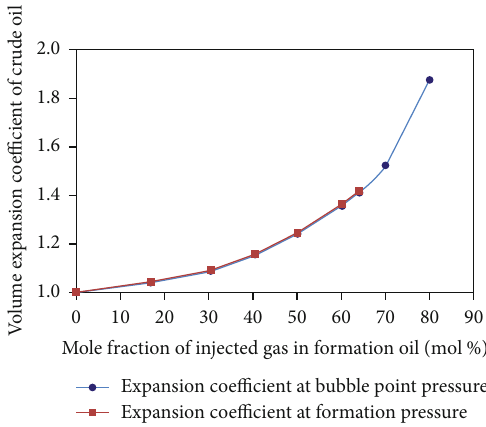
Figure 3: Variation curves of volume expansion coe ffi